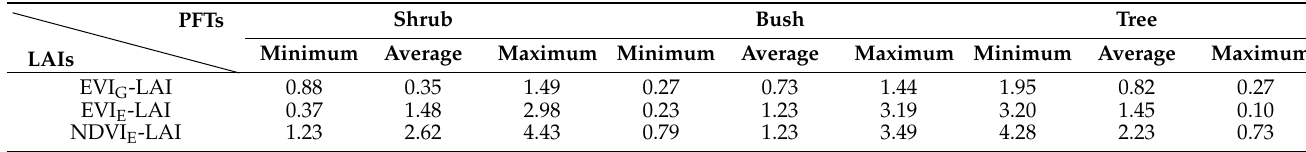
Table 6. Remote sensing LAI values for different